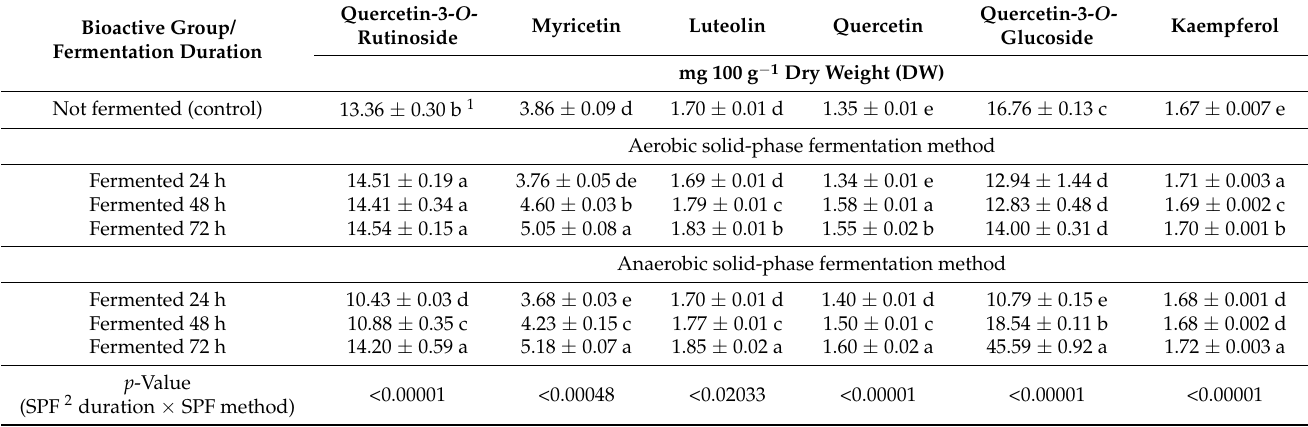
Table 3. The influence of solid-phase fermentation on the contents of individual flavonoids in fireweed